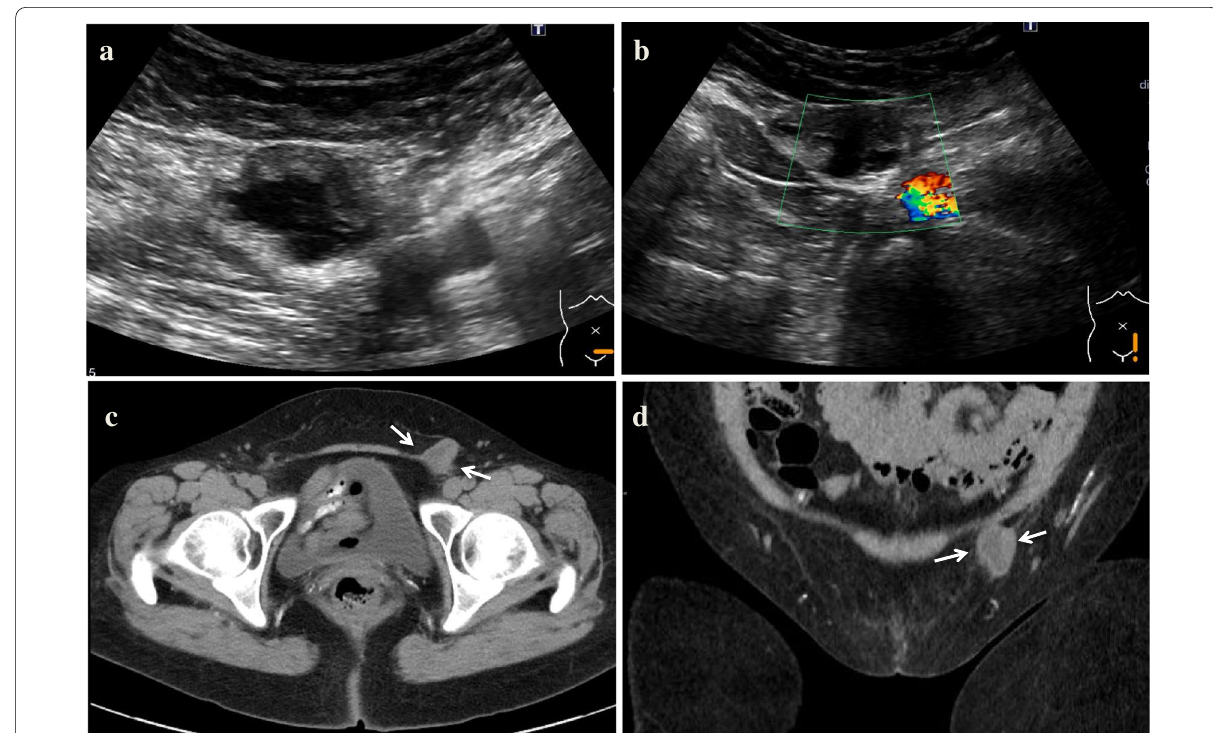
Fig. 1 Ultrasound images a US showed a cystic lesion measuring 40 mm in diameter, which had unclear boundaries and appeared hypoechoic in the inguinal canal. b The color Doppler scan did not show any internal blood vessel distribution. c CT showed the inside of the cystic lesion was liquid, with irregular hypertrophy of the cyst wall. d CT coronal image shows that the cystic is not communicating with the abdominal